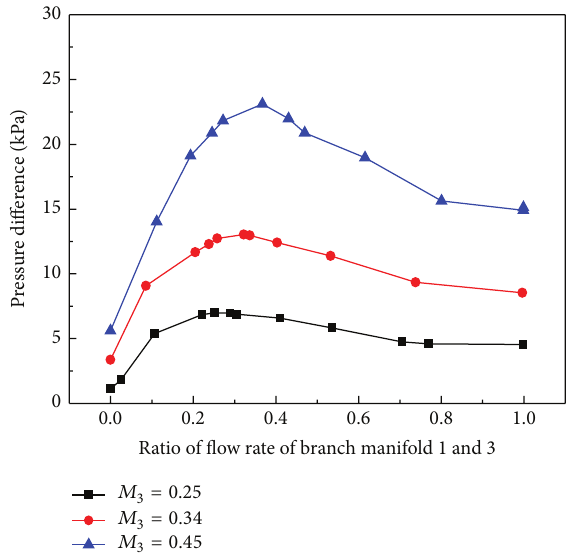
Figure 8: Total pressure loss coefficient from branch manifold 1 to branch manifold 3.